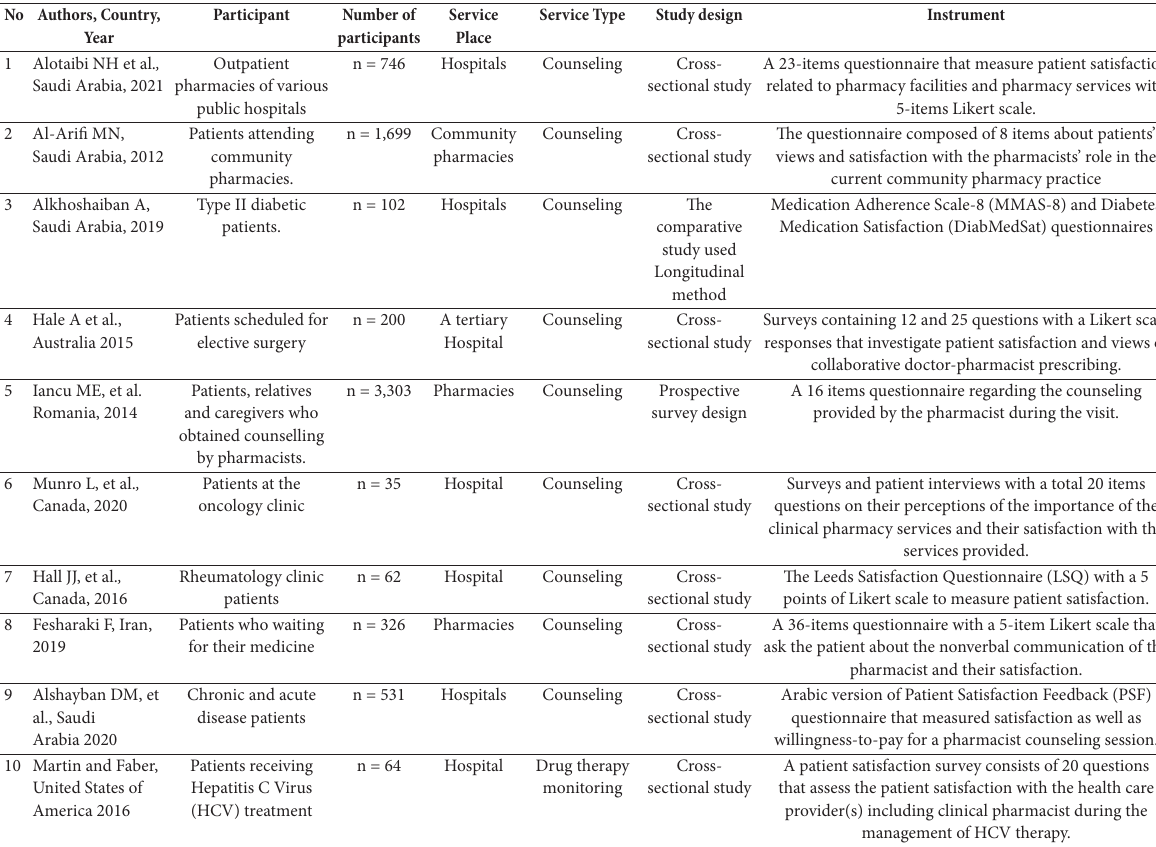
Table 1. List of patient satisfaction articles on clinical pharmacy